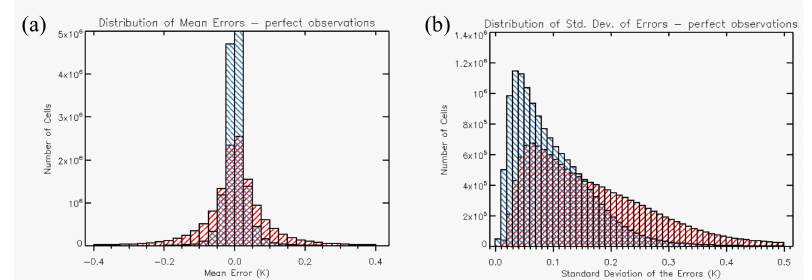
Figure 4. Statistics of the di ff erences between the analysis of January SST fields and original “truth” SST for infrared-only (IR-only) (red) and combined infrared (IR) and microwave (MW) (blue) input data: ( a ) mean error for perfect input and ( b ) standard deviation of the error for perfect